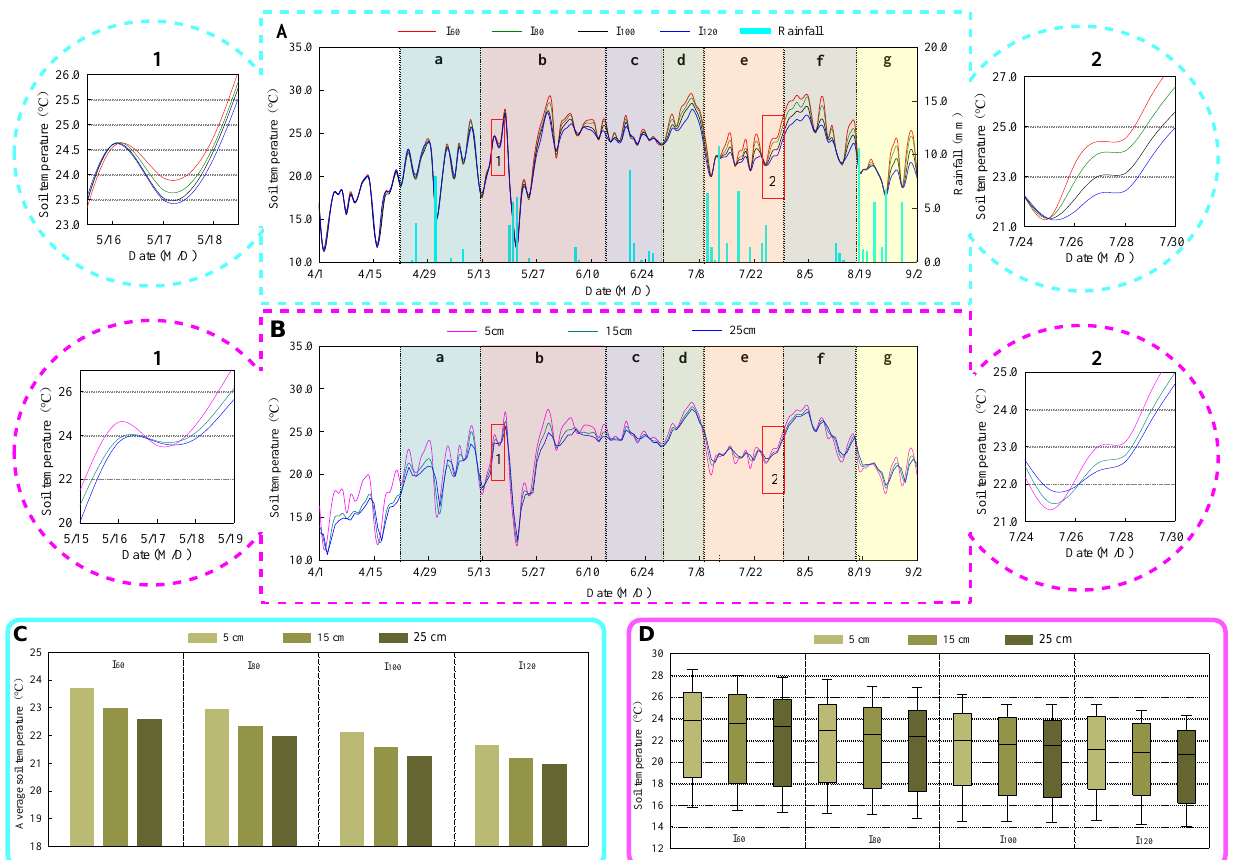
Figure 7. Mean soil temperature and rainfall during the growing season of spring maize in 2016. ( A ) Temperature at 5 cm below soil surface under different irrigation treatments; ( B ) temperature at 5, 15 and 25 cm below the soil surface under I90 treatments; ( C ) average temperature at 5, 15 and 25 cm below the soil surface in different irrigation treatments in 2016; ( D ) the daily average soil temperature at 5, 15 and 25 cm below the soil surface in different irrigation treatments in 2016. a–g are seedling stage, jointing stage, booting stage, flowering period, filling stage, milk ripe stage and maturity stage, respectively. layers from different irrigation treatments was statistically analyzed (Figures 6D and 7D). From the statistical analysis of the results, the degree of dispersion of soil tempera- ture at point T1 was larger than elsewhere. With the increase in soil depth, the degree of